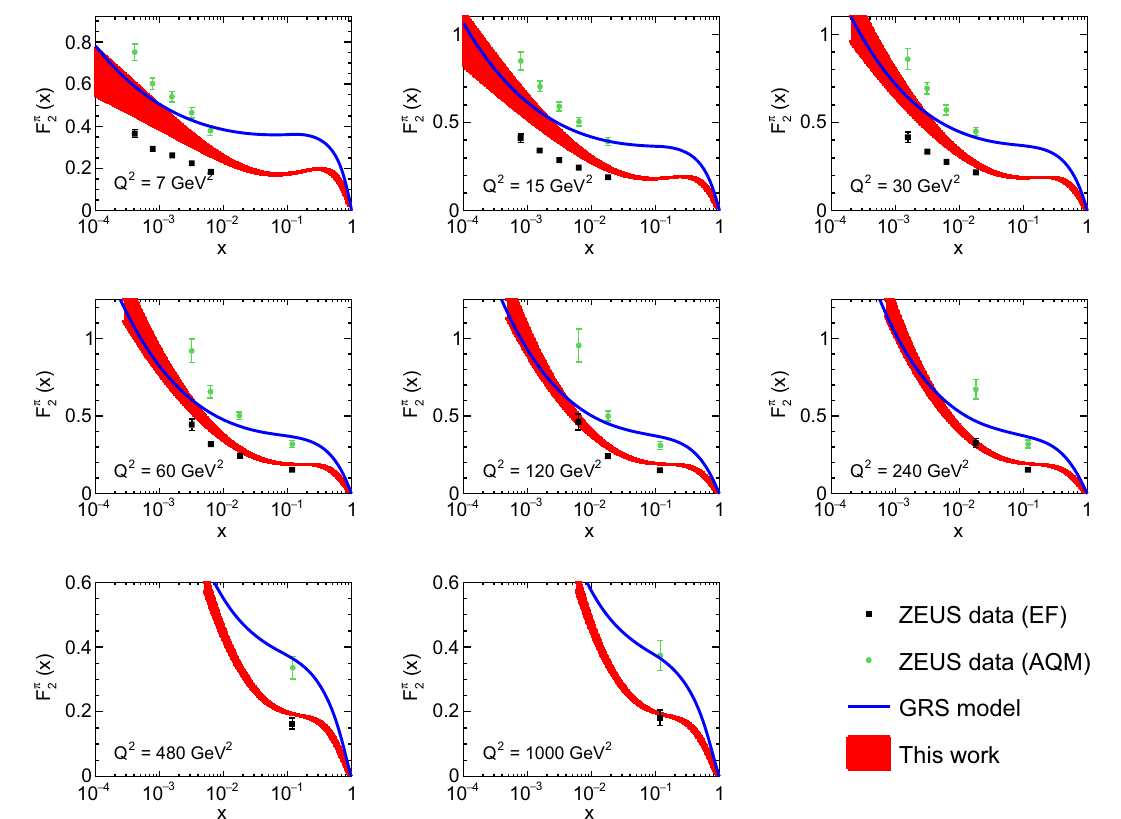
( x , Q 2 ) compared with the Fig. 5 Our predicted structure function F π different formulae (the EF model and the AQM model) [29]. The error 2 bands of this work show the 3 σ uncertainties of the structure function experimentaldatabyZEUSCollaboration[29],andtheGRSmodelpre- dictions [31]. The pion structure function data are extracted using two